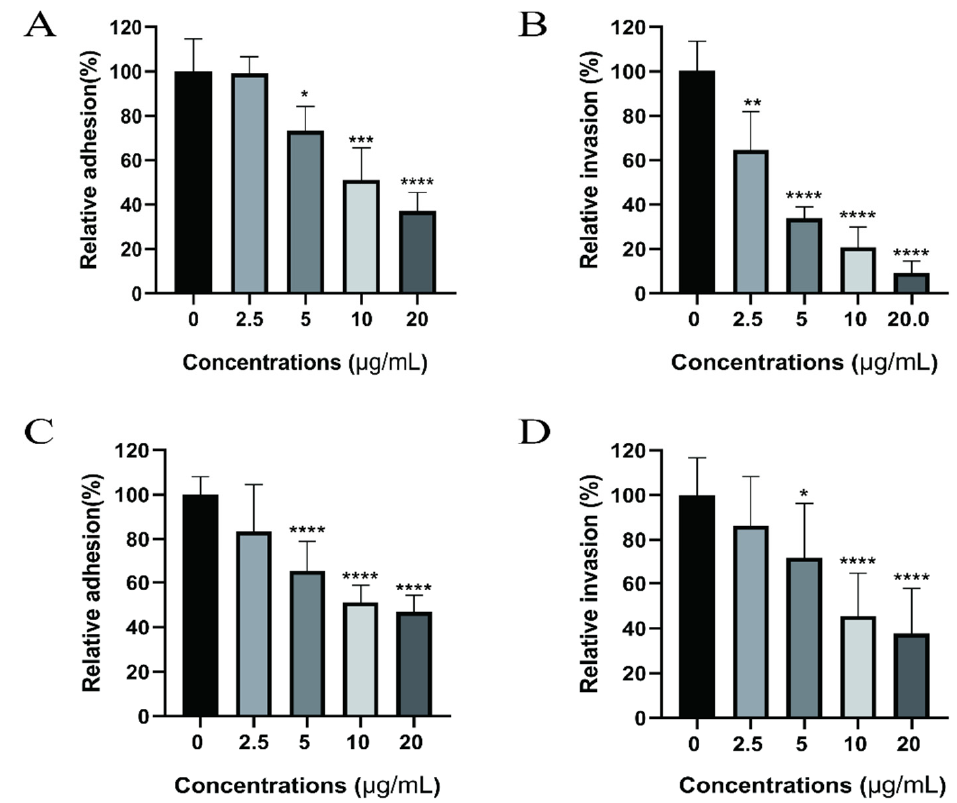
Figure 4. Effect of dictamnine on cellular adhesion and invasion by UPEC. The relative adhesion rate ( A ) and relative invasion rate ( B ) of UPEC to T24 cells after co-incubation of UPEC with T24 cells for 2 h. The relative adhesion rate ( C ) and relative invasion rate ( D ) of UPEC to T24 cells after 2 h of pre-incubation of dictamnine with T24 cells. Values represent the mean ± SD from three independent experiments with three technical replicates. * p < 0.05, ** p < 0.01, *** p < 0.001, **** p < 0.0001.